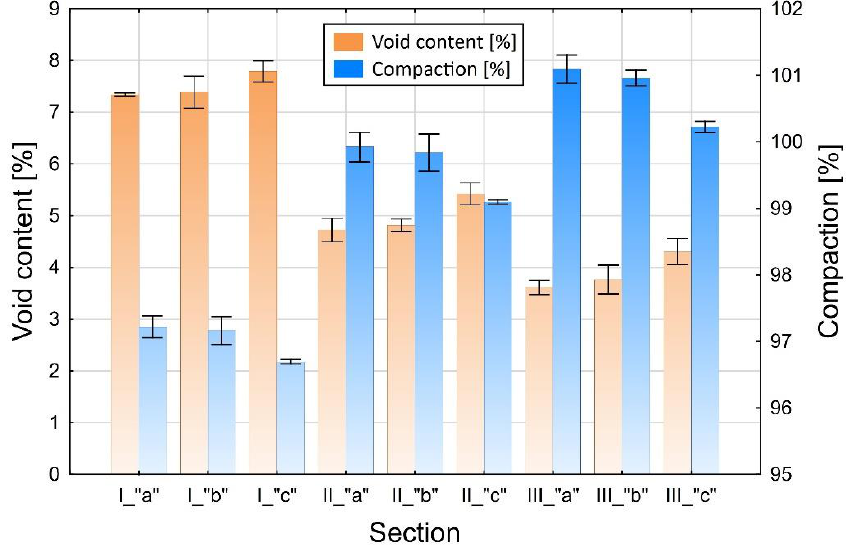
Figure 5. Compaction and air void content in the cores taken from the 4 cm thick binder course depending on the location. The zone and section designations are the same as in Figure 3.